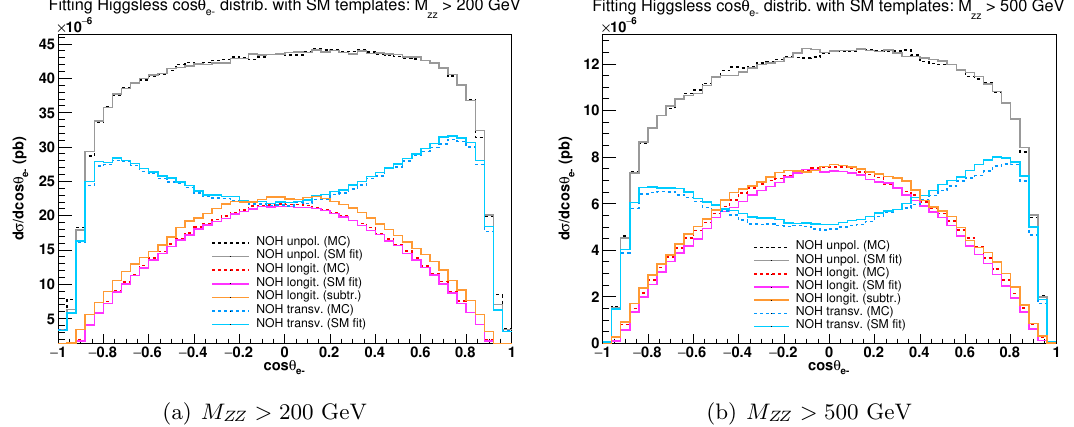
Figure 14 . ZZ scattering: (cid:12)t of the Higgsless unpolarized cos (cid:18) Fitted and expected di(cid:11)erential cross sections in two ZZ invariant mass regions. For the longitudinal component the result of the (cid:12)t (magenta) and the one of the subtraction technique (orange) are compared with the Monte Carlo expectations (dashed